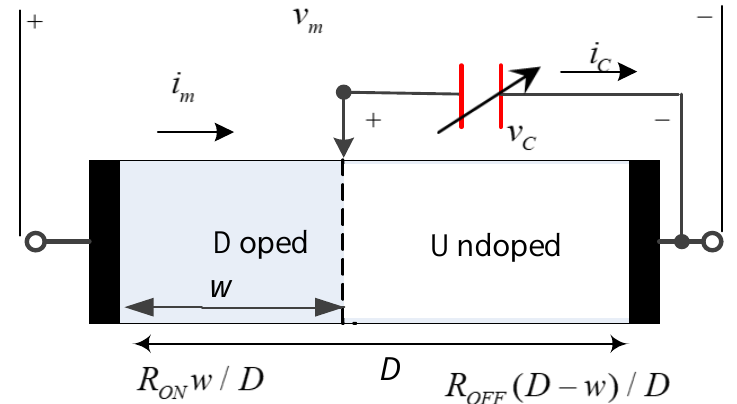
Figure 6. Structure of the HP TiO 2 memristor.